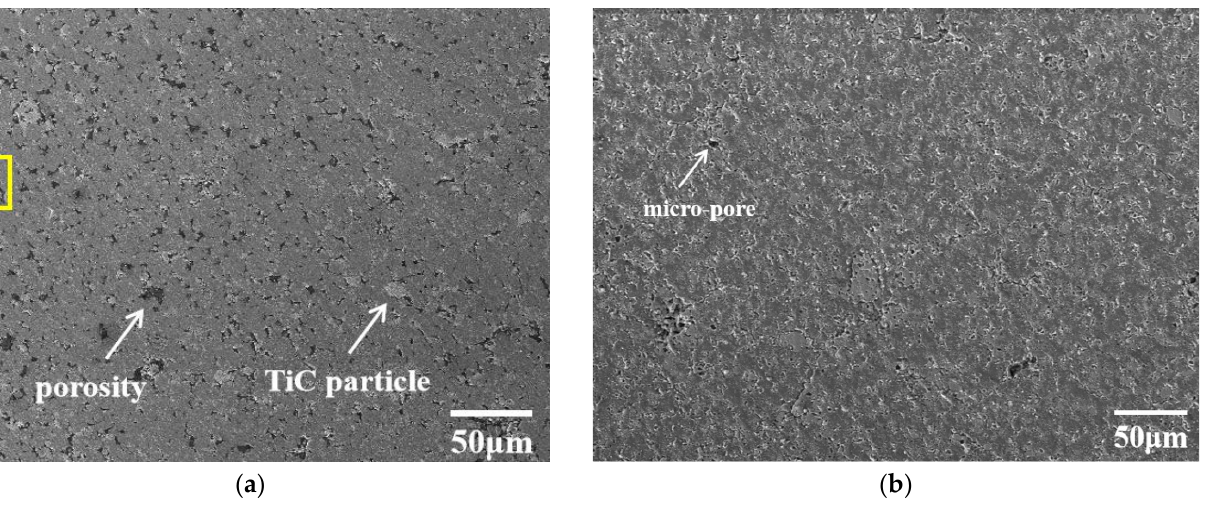
Figure 3. SEM images of Al-20TiC composites before and after HCPEB treatment: ( a ) initial sample; ( b ) 5-pulse-treated sample; ( c ) 15-pulse-treated sample; ( d ) 25-pulse-treated